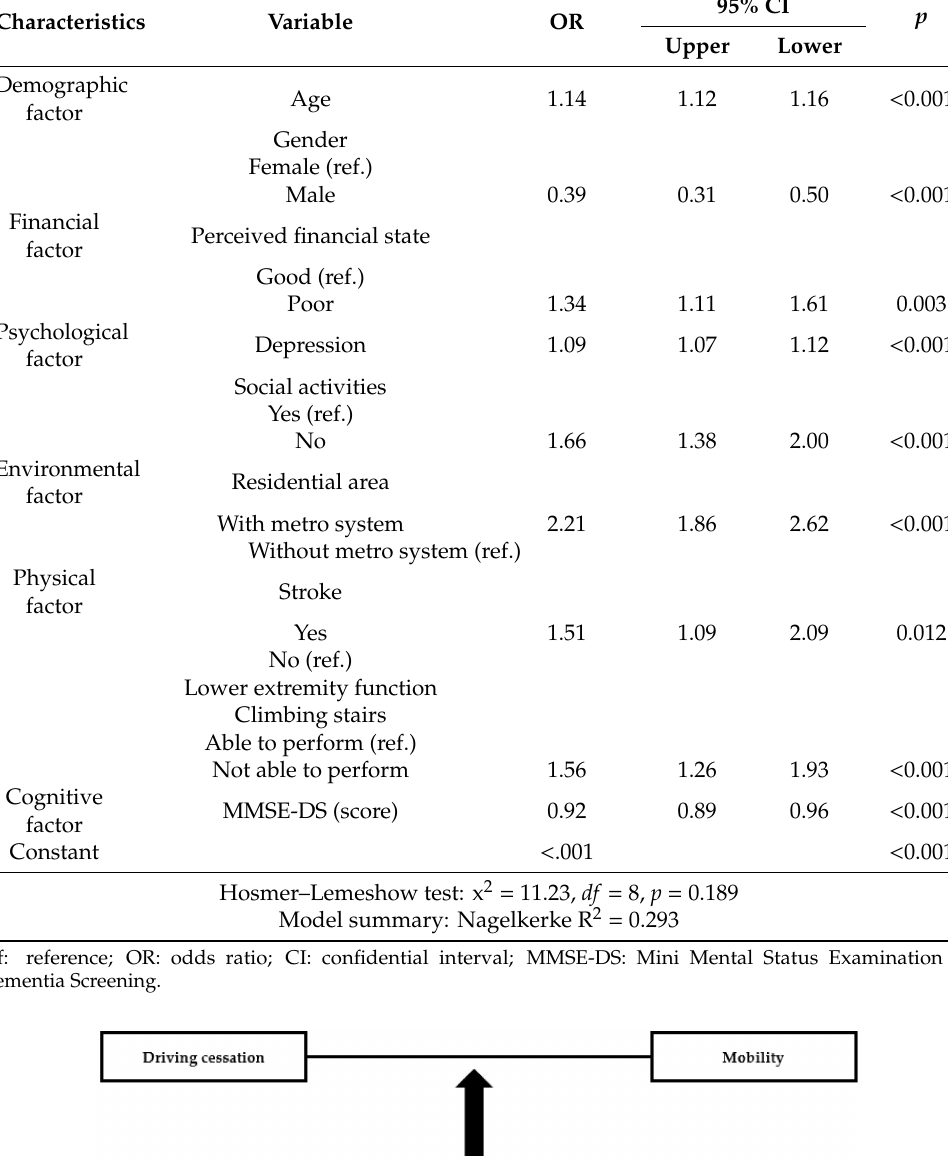
Table 3. Multivariate logistic regression models for driving cessation ( N = 2970).